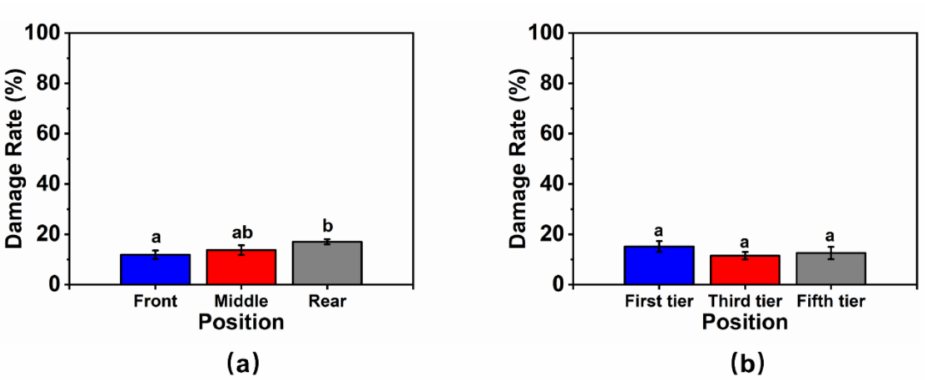
Figure 9. Damage rates of different positions in a lorry after road transportation (Road Test B): ( a ) Damage rates of fruit at the front, middle, and rear of the lorry. ( b ) Damage rates of fruit at the first, third and fifth tiers. Vertical bars represent standard error. Letters on columns indicate significant differences ( p <